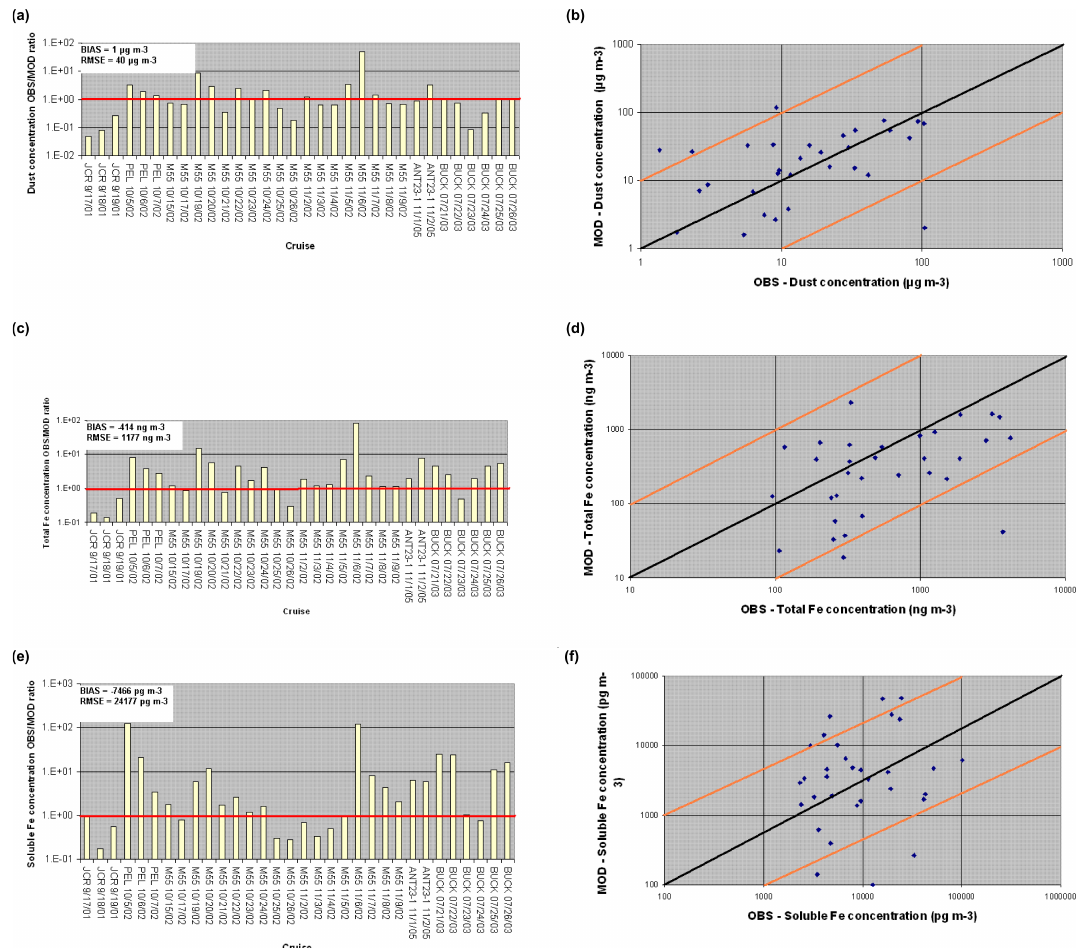
Fig. 4. Observations/model ratios of daily C , T and S along the G1 cruise paths ( (a) , (c) and (e) panels); model vs. observations scatter diagrams of daily C , T and S along the G1 cruise paths ( (b) , (d) and (f)